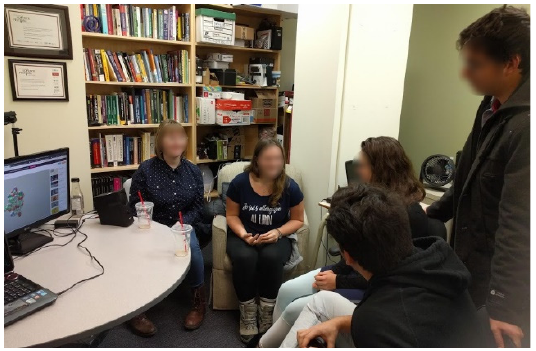
Figure 1. Students discussing the molecular sonification design.